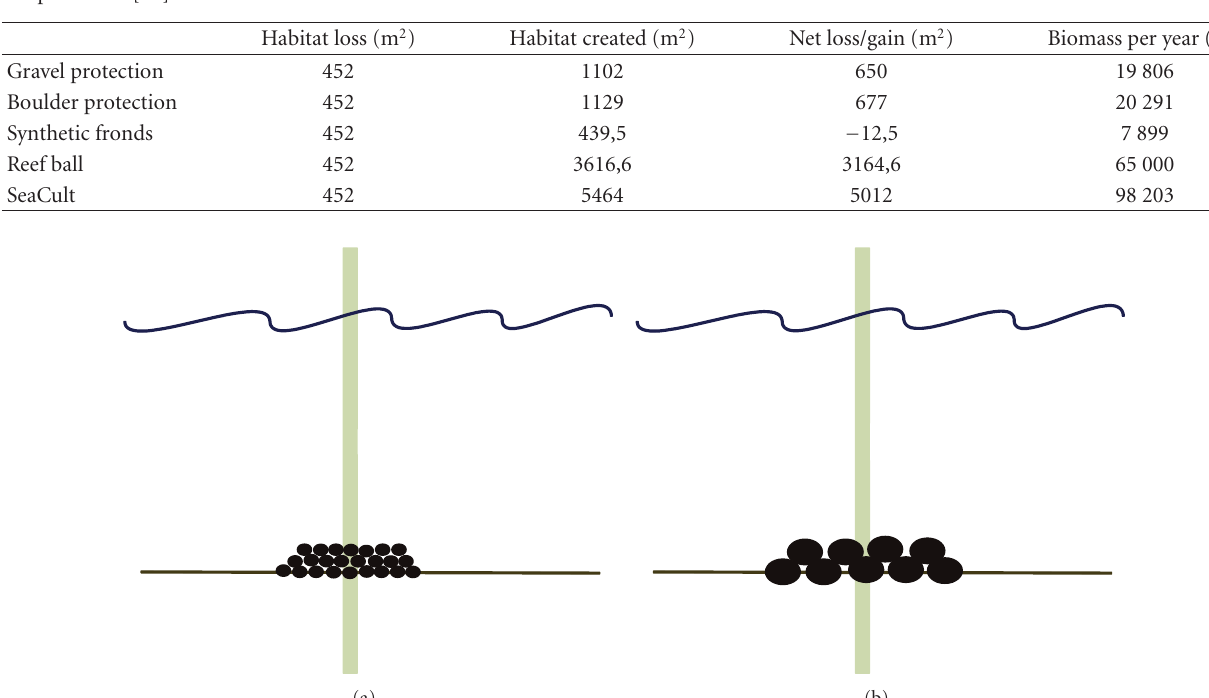
Table 1: Net habitat loss and gain through the installation of di ff erent types of scour protections around an o ff shore wind turbine and calculated biomass of expected motile organisms. The expected carrying capacities have been calculated based on reef ball observations. Adapted from [13].